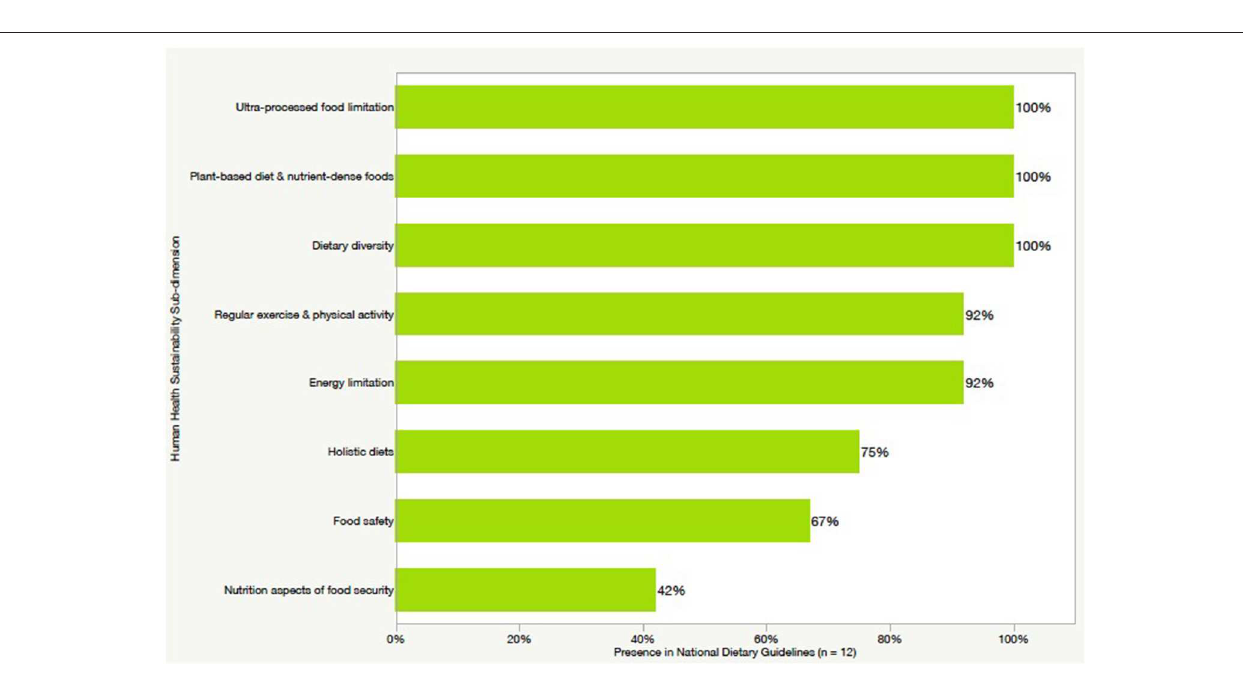
integrative sustainability approach to dietary recommendations helps support multiple Sustainable Development Goals